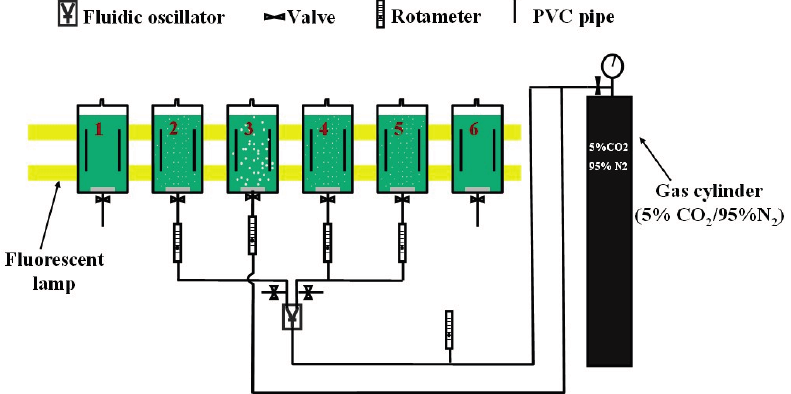
Figure 3. Setup for D. salina cultures. Six bioreactors containing D. salina cultures (50 mL of